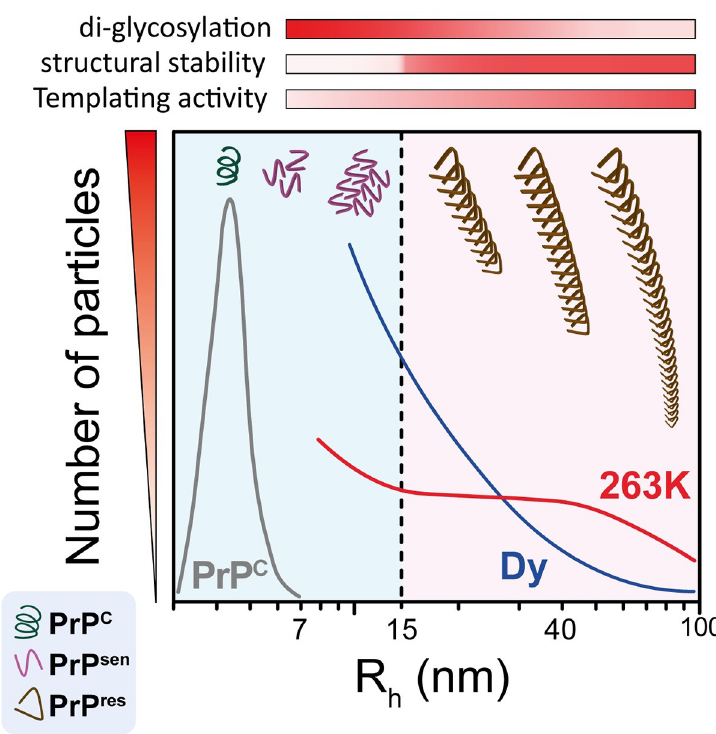
Fig 8. Proposed model of PrP Sc structural heterogeneity. A continuum of PrP Sc quaternary structures accumulate in the brain of prion-infected animals. Whereas the size of PrP Sc particles is the main contributor to PrP Sc heterogeneity, a major change in the core structure occurs when 15 nm R h is reached, generating two distinctive subpopulations that define the properties of the prion strain. At this size, there is a substantial increase in resistance to proteolysis and a reduction in the incorporation of di-glycosylated PrP isoforms into the PrP Sc particles. Once the mature PrP res particle is formed, the structural stability and glycosylation patterns remain constant despite further addition of PrP monomeric units. The PrP Sc templating activity is also affected by the size of the particle, increasing as the particle size increases, as seen in the case of DY.